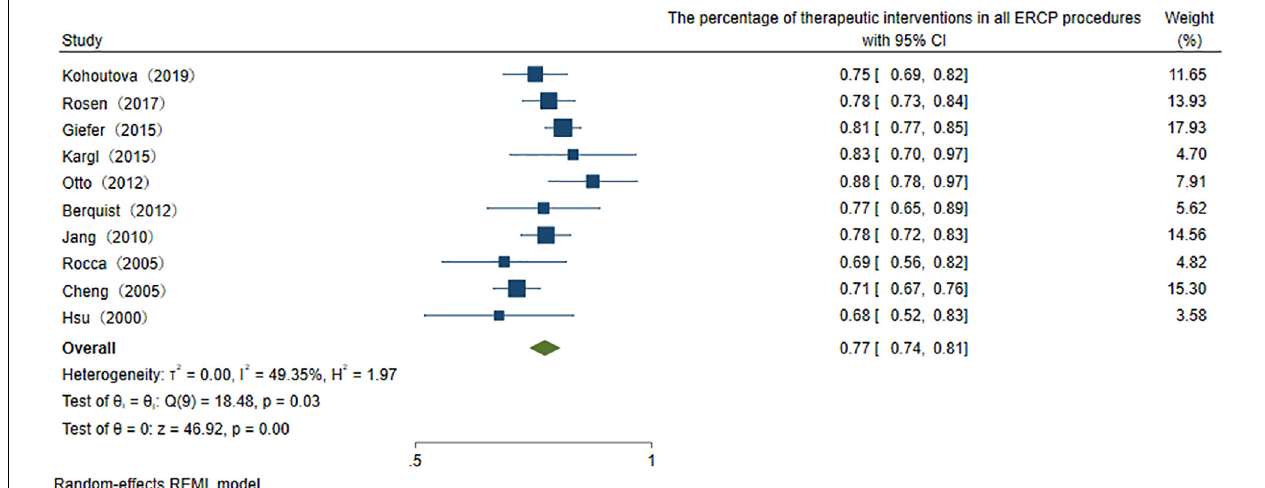
FIGURE 2 | The percentage of therapeutic interventions in all ERCP procedures.